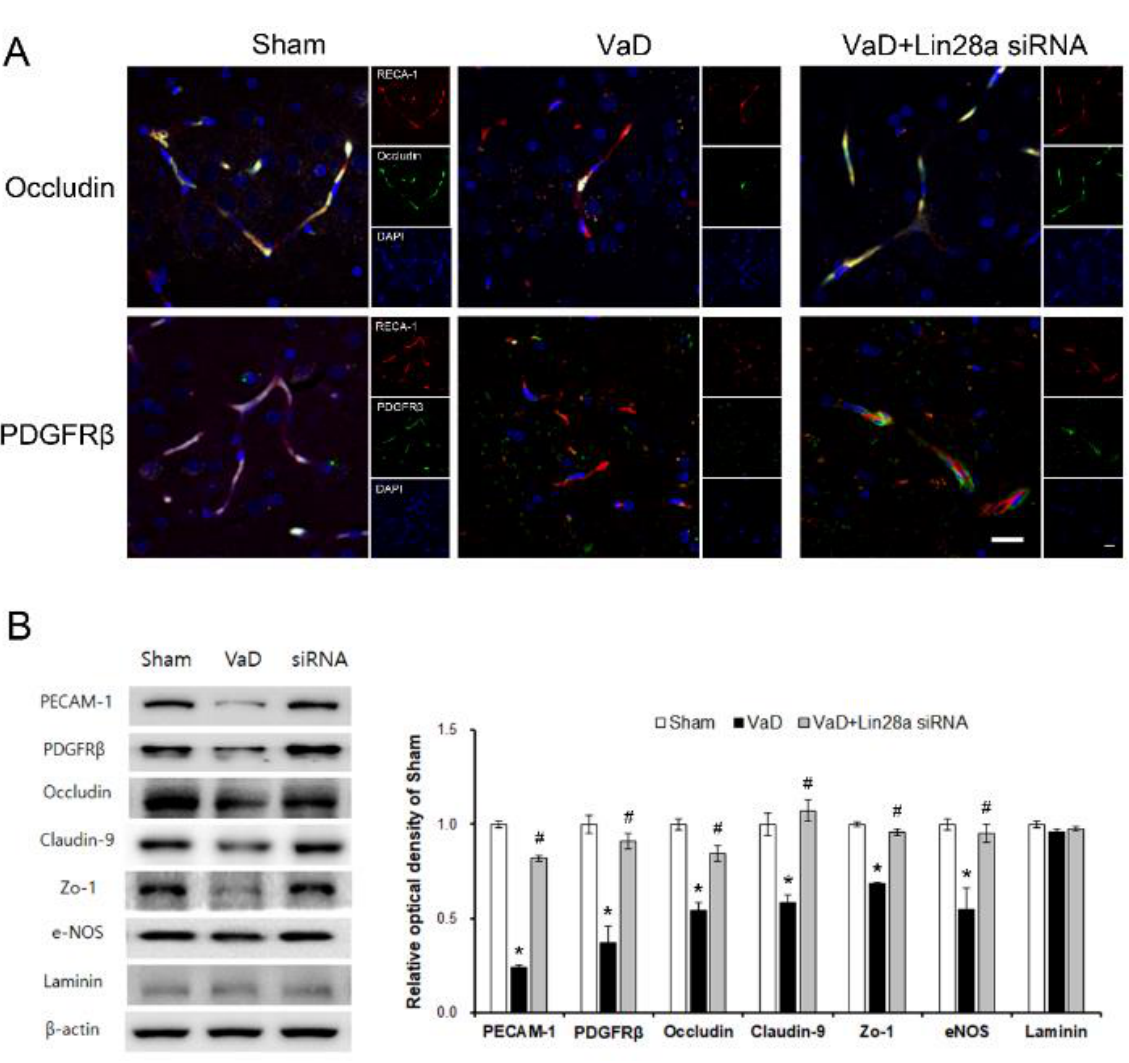
Figure 3. Blocking Lin28a ameliorates the loss of tight junction proteins in the brain. ( A ) Representa- tive photographs of immunofluorescent staining of occludin (green), PDGFR β (green), and RECA-1 (red) in the brain. ( B ) Representative bands of PECAM-1, PDGFR β , occludin, claudin-9 and ZO-1, eNOS, and Laminin proteins in the brain were detected by western blotting. The data are presented as the mean ± S.E.M. * p < 0.05, compared to the sham group. # p < 0.05, compared to the VaD group. A scale bar represents 20 μm .